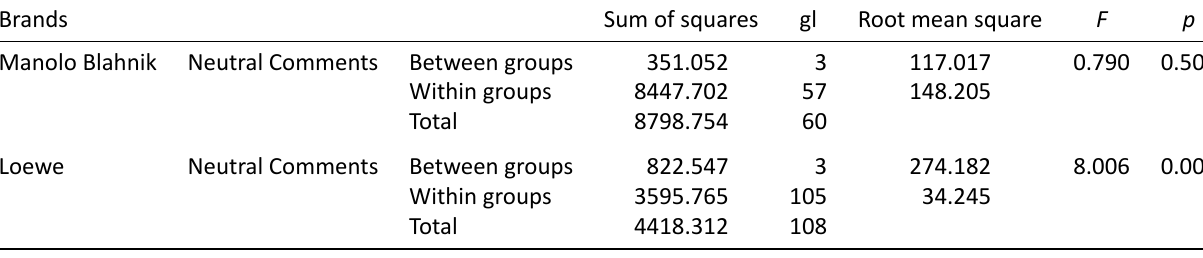
Table 7. ANOVA statistic of the neutral comments as a function of brand content.